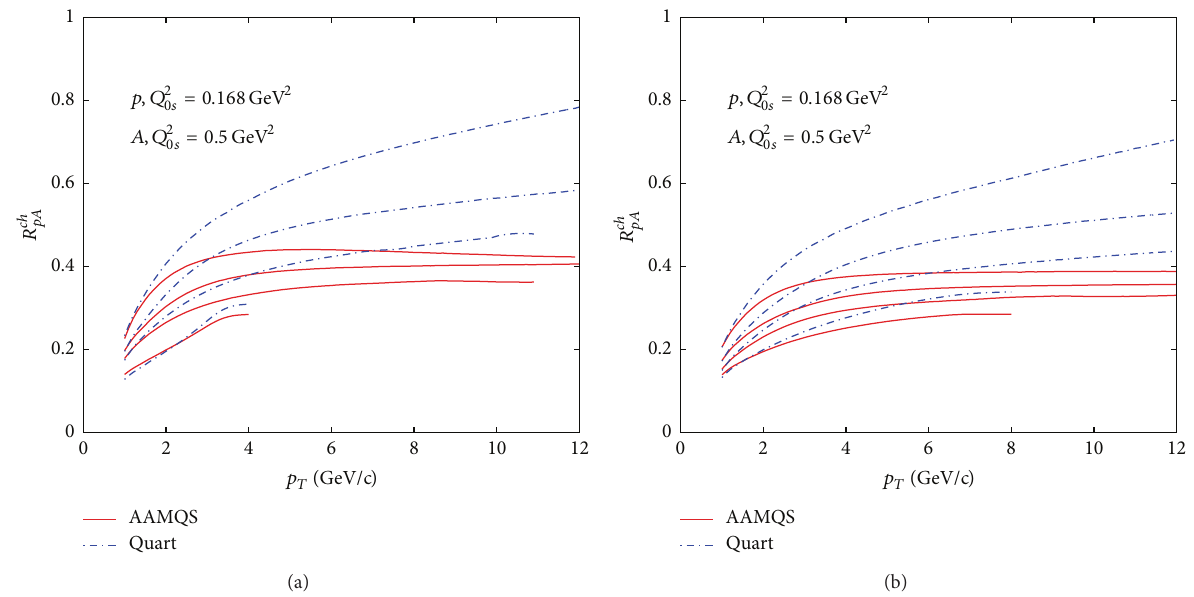
Figure 7: Nuclear modification factor 𝑅 𝑐ℎ 𝑝𝐴 versus 𝑝 𝑇 for inclusive charged hadrons ℎ + +ℎ − production in minimum-bias 𝑝 +Pb ( 𝐴 = Pb in 𝑝𝐴 ) collisions at the LHC energies, with the pseudorapidity being 4, 5, 6, and 7 from the upper curve to lower one. The solid and dashed-dotted curves represent the results calculated by the AAMQS and quartic action, respectively, with 𝑄 2 0𝑠 = 0.168 GeV 2 for 𝑝 and 0.5 GeV 2 for Pb in the calculations. (a) corresponds to √𝑠 𝑁𝑁 = 4.4 TeV with 𝑁